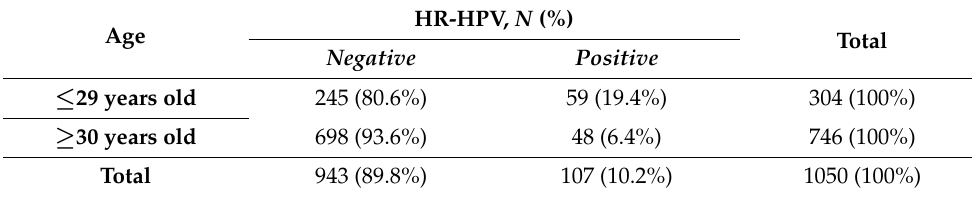
Figure 2. Frequency of HR ‐ HPV positive in the total number of tested women ( N = 1050). HR-HPV infection was statistically significant higher in women aged ≤ 29 years, in 19.4%, while in the group aged ≥ 30 years, 6.4% was HPV positive ( p < 0.001) (Table 4). Table 4. Frequency of HR ‐ HPV positive women according to age ( N = 1050).